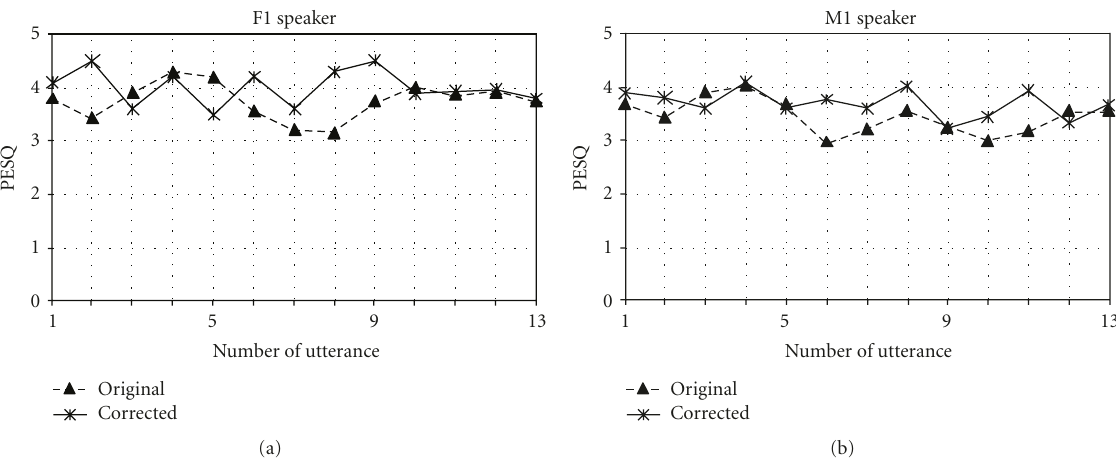
Figure 9: PESQ scores of original (degraded) and corrected utterances pronounced by F1 and M1 Acadian French speakers a ff ected by SSD.